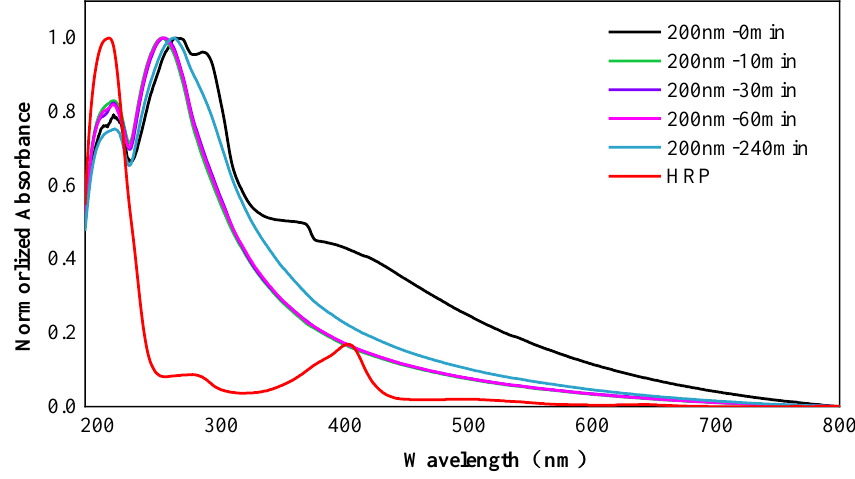
Figure 7. UV-vis adsorption spectra of PS NPs, HRP and PS-HRP PC over time.